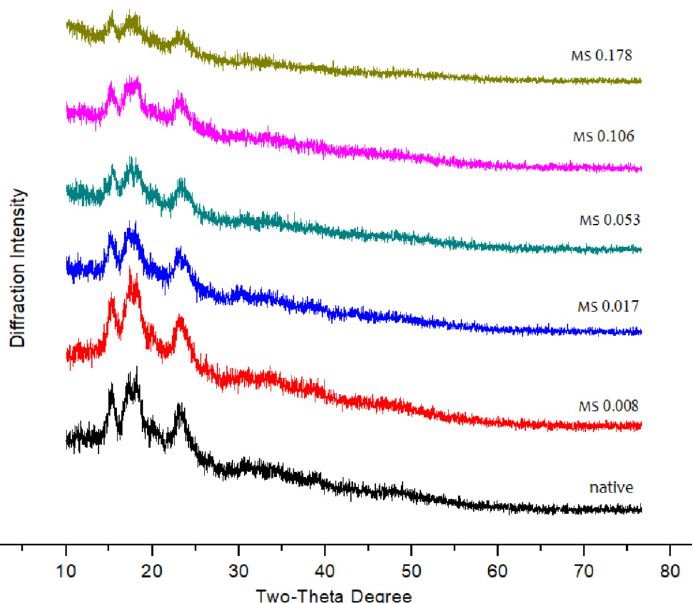
Figure 2. X-ray diffraction patterns of native and hydroxypropylated starches.